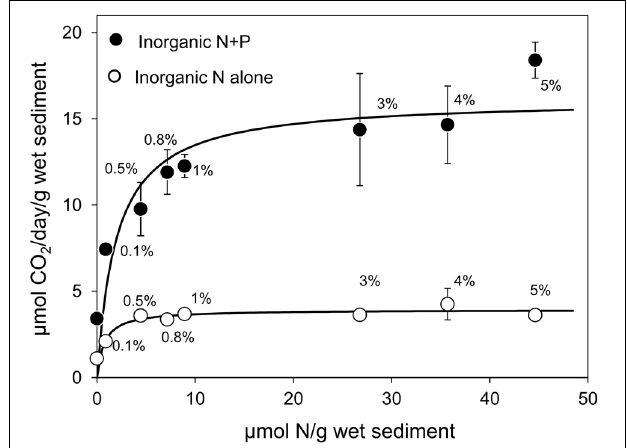
FIGURE 1 | Effect of inorganic N treatment alone (0–5% N w/w of oil—open circles) or inorganic N (0–5% w/w of oil) with constant P (0.5% w/w of oil) treatment (filled circles) on the rate of CO 2 production in microcosms containing 10g beach sediments and 125mg North Sea crude oil. Data are plotted as micromoles N/g sediment with the equivalent %N w/w of oil annotated next to each data point. Sodium nitrate and potassium dihydrogen phosphate were used as N and P sources. Each data point represents the average value of three replicates. Where error bars are not seen they are smaller than the symbols. Control incubations with nutrients and no added oil were also conducted to determine the contribution of indigenous organic carbon to CO2 production. These typically gave values of 1.05 ± 0.27 µ mol CO2/g wet sediment/day (see Figure S1